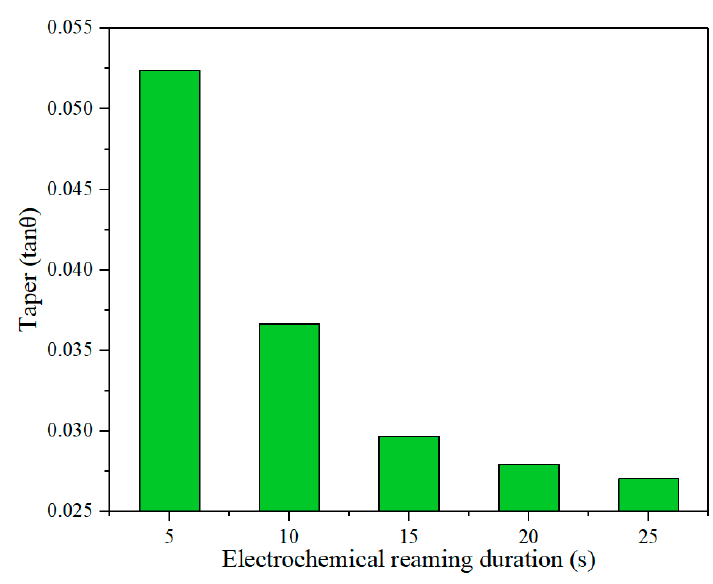
Figure 21. E ff ect of duration of electrochemical reaming on hole taper. Figure 21. Effect of duration of electrochemical reaming on hole taper. Figure 21. Effect of duration of electrochemical reaming on hole taper.